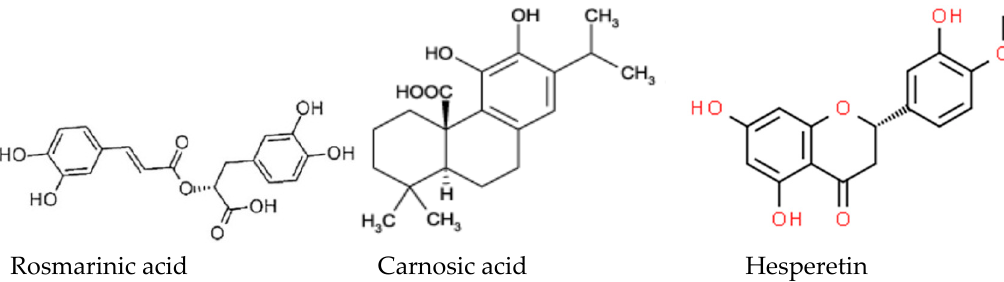
Figure 1. Chemical structure of the major antioxidative compounds in rosemary extracts.